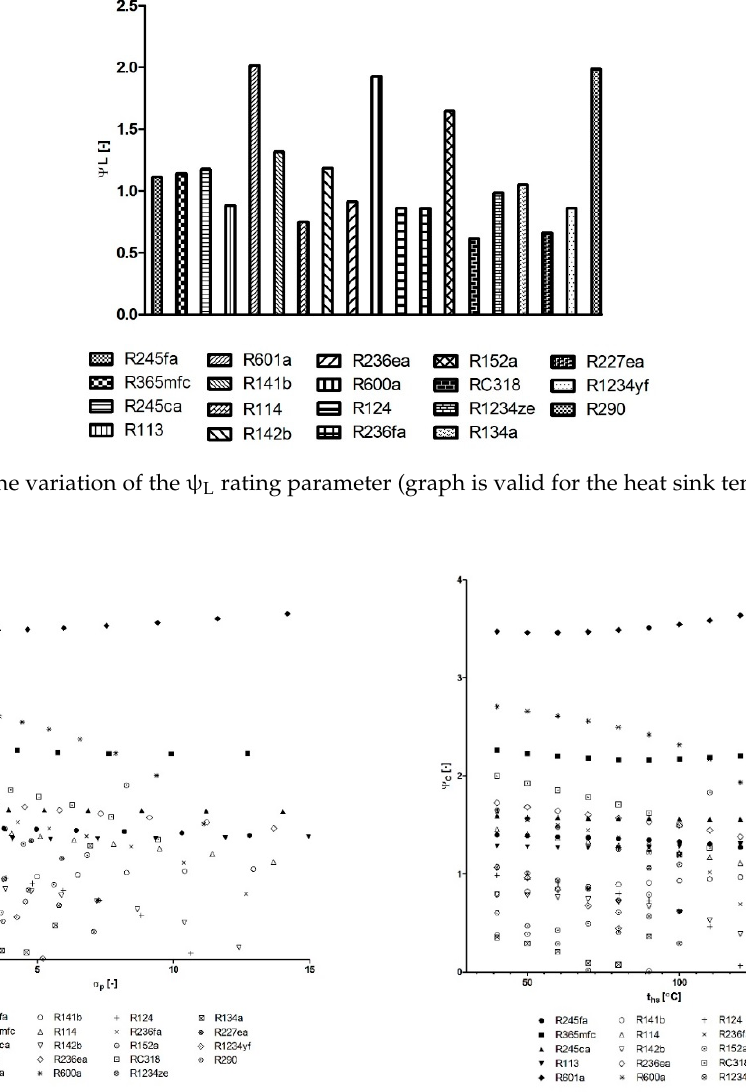
= f( σ = f(t ψ ψ C P ); ( b ) C hs